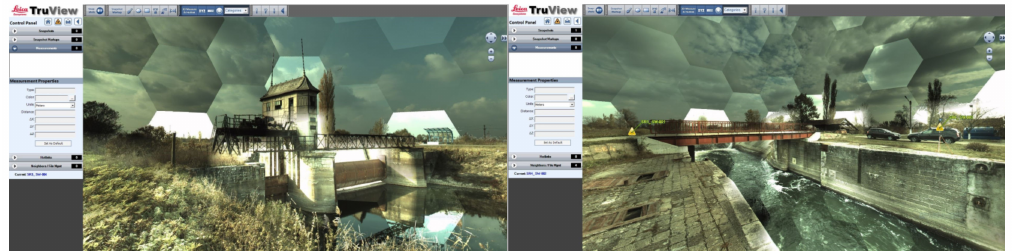
Figure 21. TruView link for NH Topolov ă ¸tu Mic.